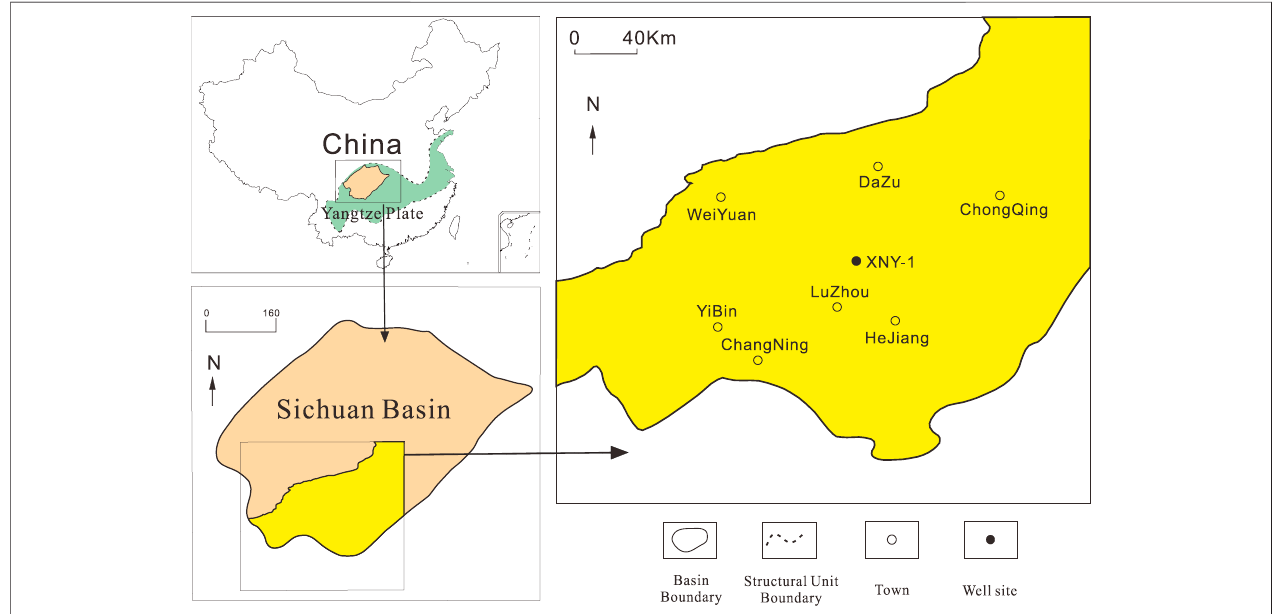
FIGURE 1 | Location of the southern Sichuan Basin in southern China and the distribution of XNY-1 well. Modi fi ed from references (Mei et al., 2012; Wang et al., 2015; Mou et al., 2016; Zhang et al., 2019a; Zhang et al., 2020a).